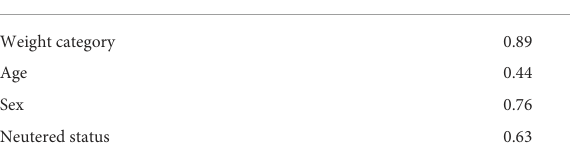
TABLE 2 P -value obtained for each one of the dog’s physiological-related parameters after statistical